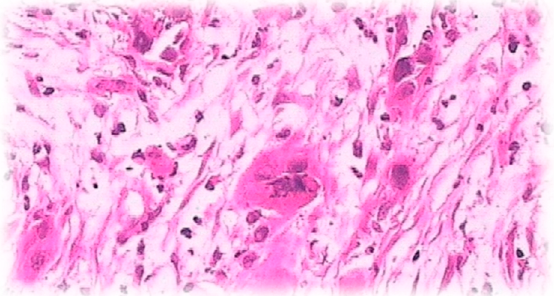
Figure 7. ED3: a representative case of angiosarcoma of the right atrium in a 40-year-old woman: blood vessels are covered by atypical endothelial cells and surrounded by spindle cells.